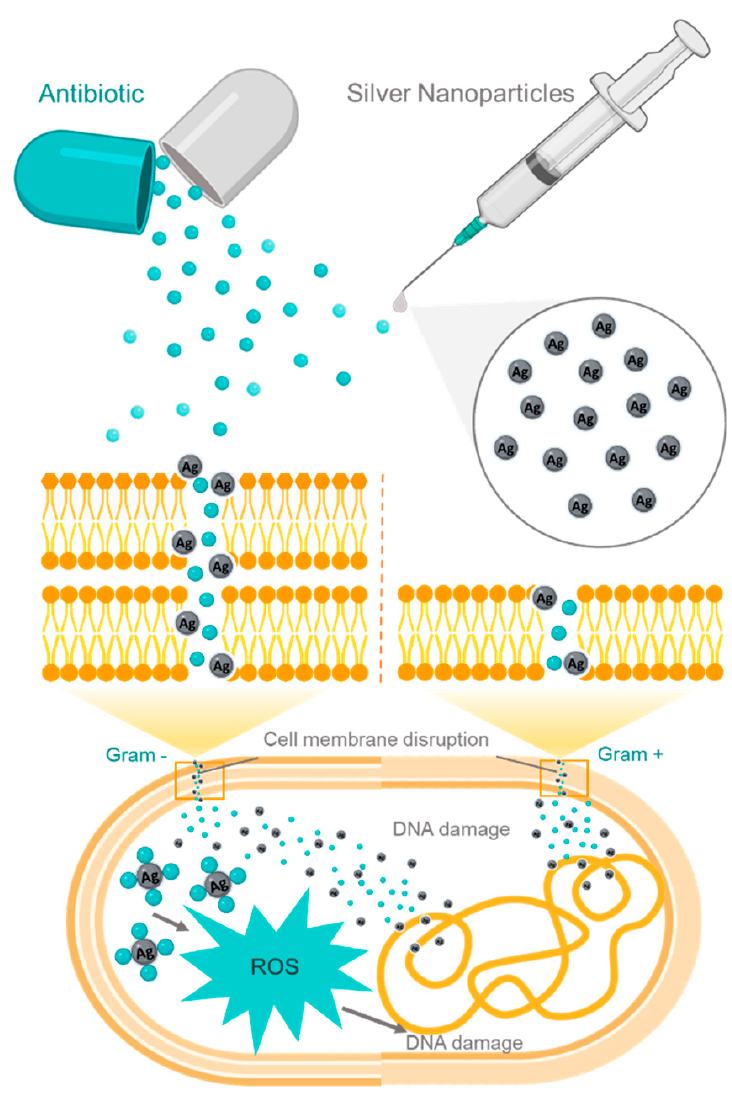
Figure 2. Representative illustration of the interaction between antibiotics and Ag-NPs and their combined action inside both Gram-negative ( left ) and Gram-positive ( right ) bacteria. Although there is a thicker path for Ag-NPs and antibiotics to travel through with the Gram-negative bacteria membrane, once, inside the cell, the mechanisms are the same as for Gram-positive bacteria: accumulation of particles inside the cell; production of ROS; and ultimately cell death by damaging the bacterial DNA (adapted from [111]).